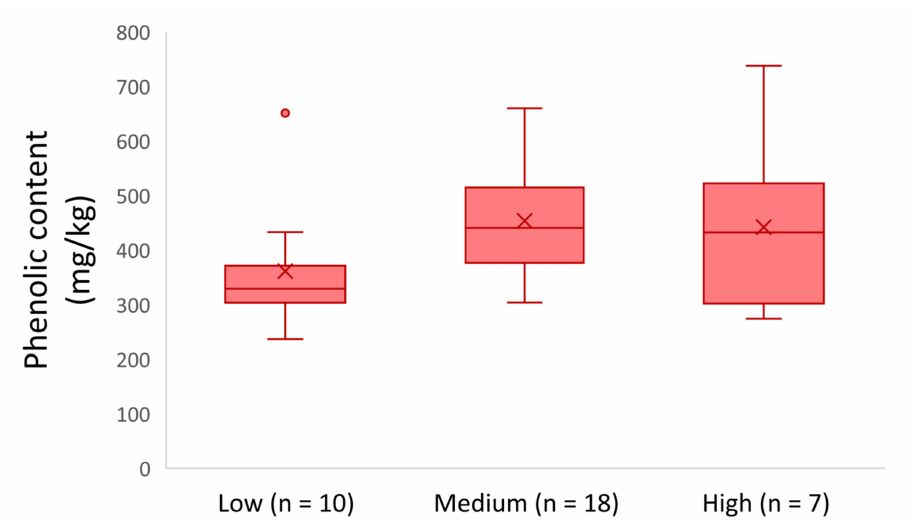
Figure 3. Phenolic content of the analyzed EVOOs produced in 2016–2017 with respect to the altitude.